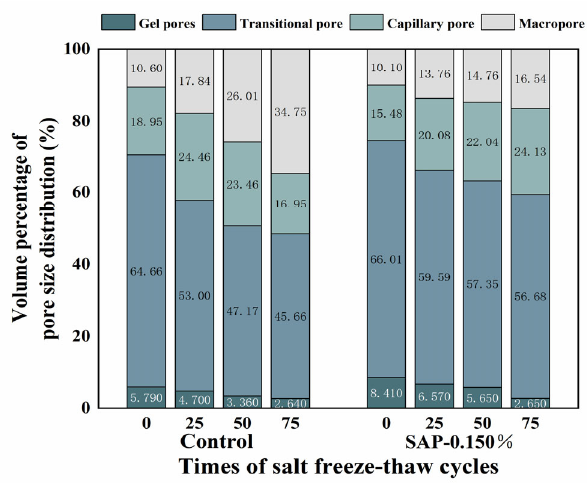
Figure 10. Cumulative pore volume percentage with salt freeze–thaw cycles times.